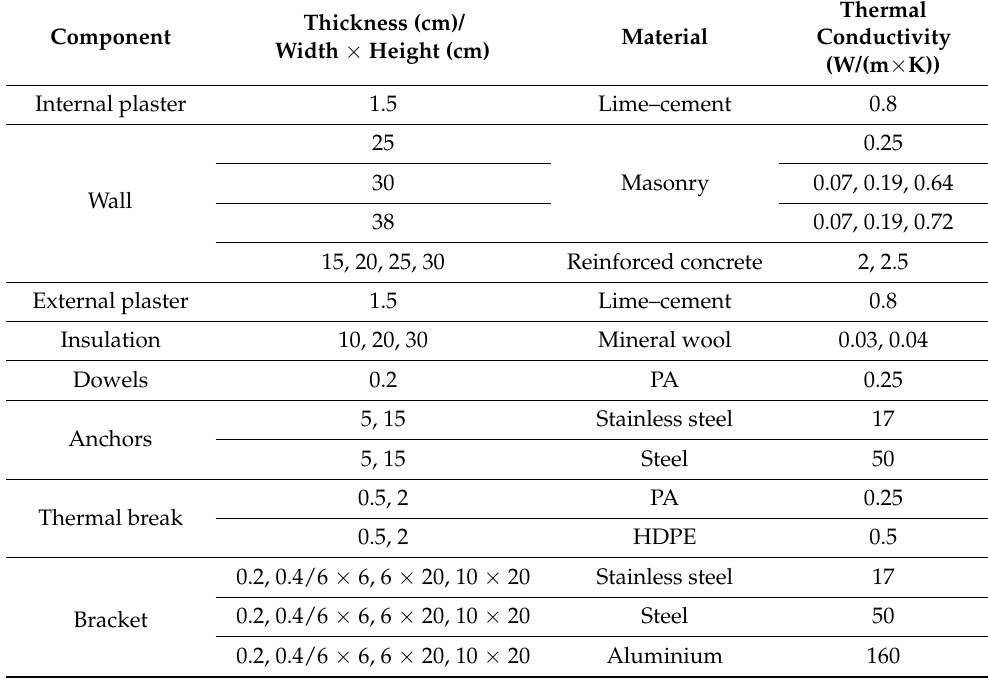
Table 1. Parameters used in the